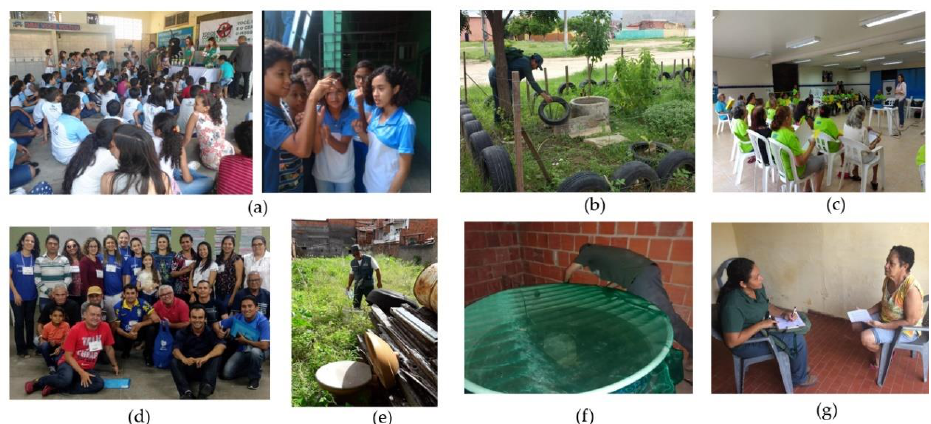
Figure 2. Intervention. ( a ) school activities, ( b ) elimination of breeding sites, ( c ) community groups, ( d ) training in EBS strategy for endemic diseases’ workers, social mobilizers, AVISA, and stakeholders, ( e ) cleaning of vacant lots, ( f ) sealing of water tanks, ( g ) study on the cost of arboviruses to the community.